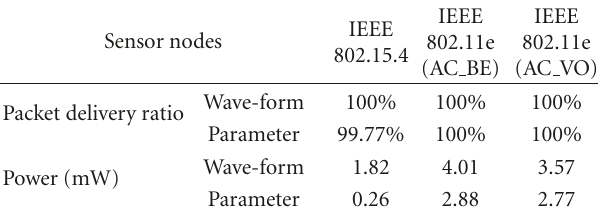
Table 4: Packet delivery ratio and power (in